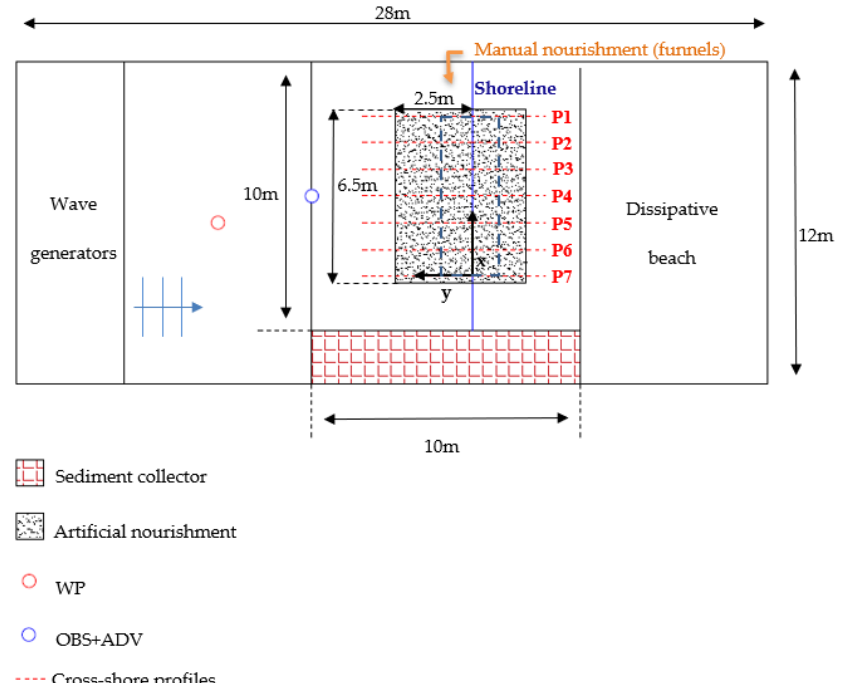
Figure 2. Beach plan scheme at the wave basin. The area represented by a blue dashed rectangle, above the nourishment, represents the monitored cell.